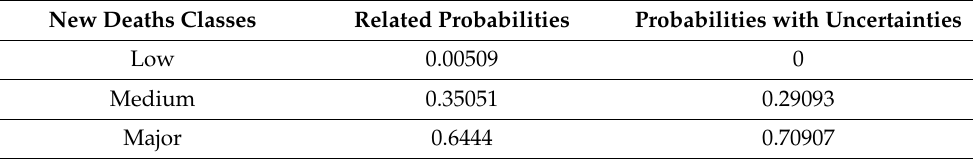
Table 13. New deaths classes probabilities. Results obtained by